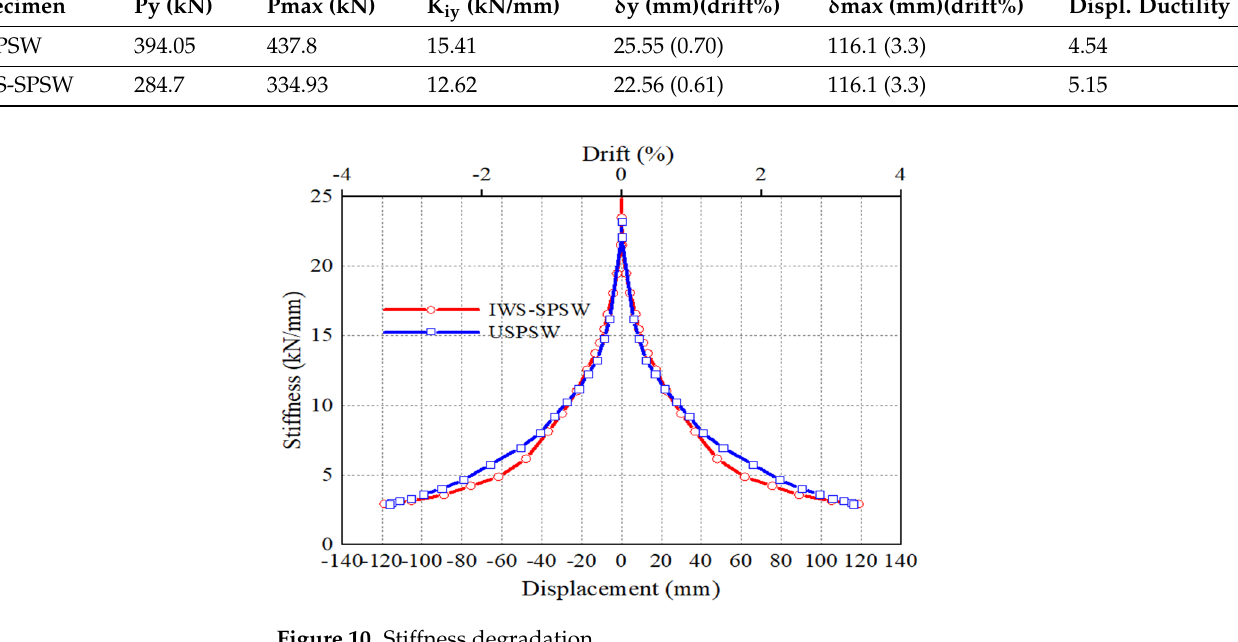
Figure 10. Stiffness